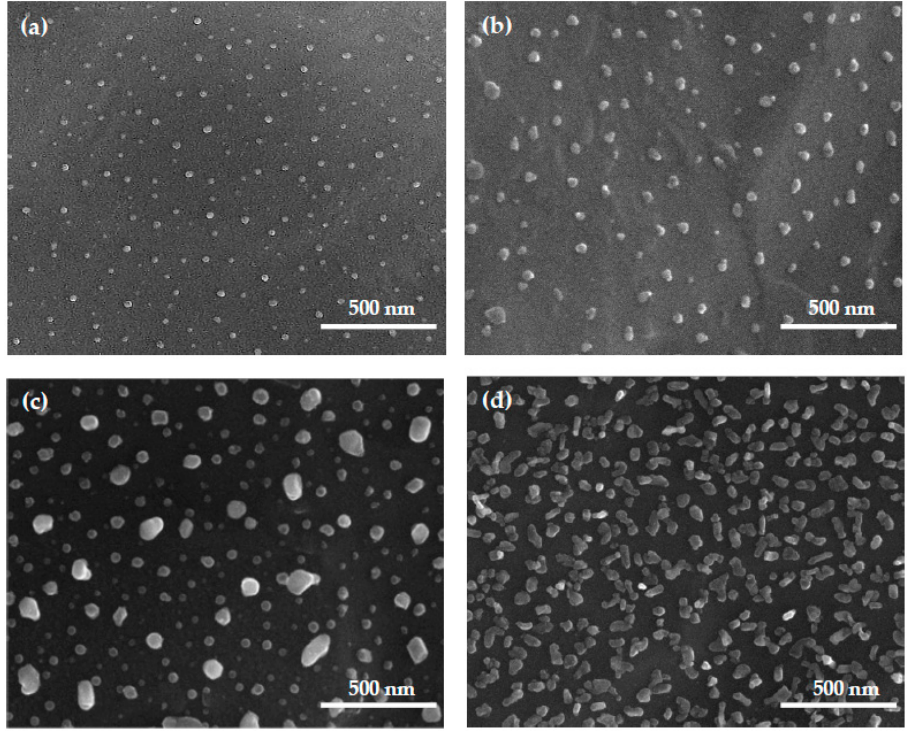
Figure 1. The scanning electron microscopy (SEM) images of Ti6Al4V/0.9AgNPs; d = 18 ± 8 nm ( a ), Ti6Al4V/1.1AgNPs; d = 45 ± 15 nm ( b ), Ti6Al4V/1.3AgNPs; d = 68 ± 32 nm ( c ), Ti6Al4V/2.3AgNPs; d = 53 ± 18 nm ( d ).